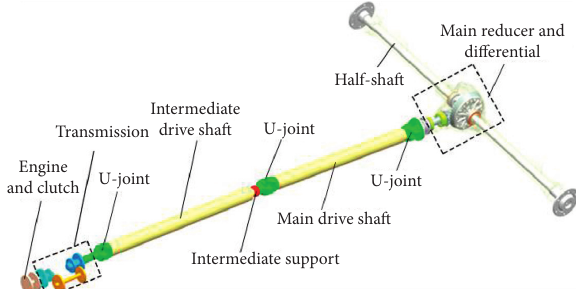
Figure 1: Schematic of the automotive powertrain system dis- cussed in this